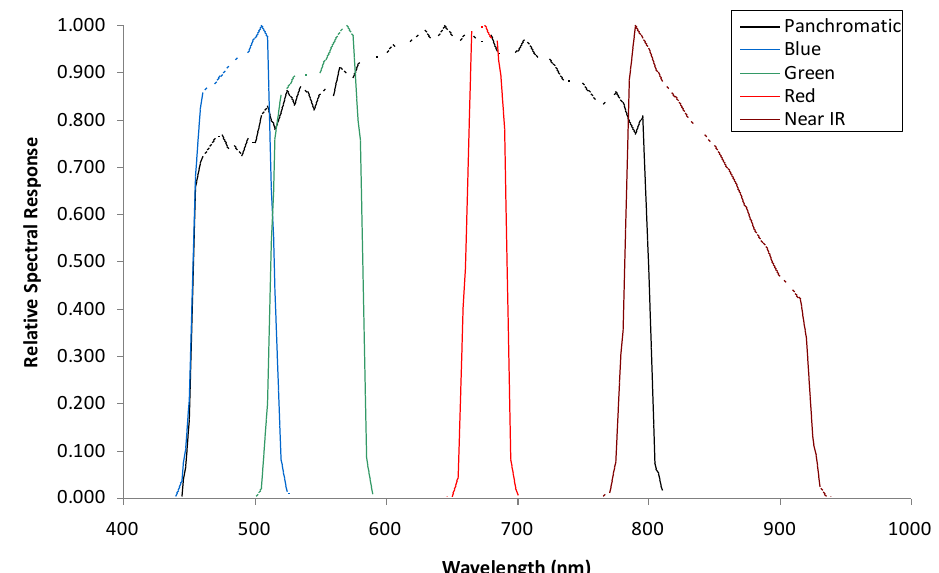
Figure 2. GeoEye1 satellite relative spectral response in the visible and NIR spectral